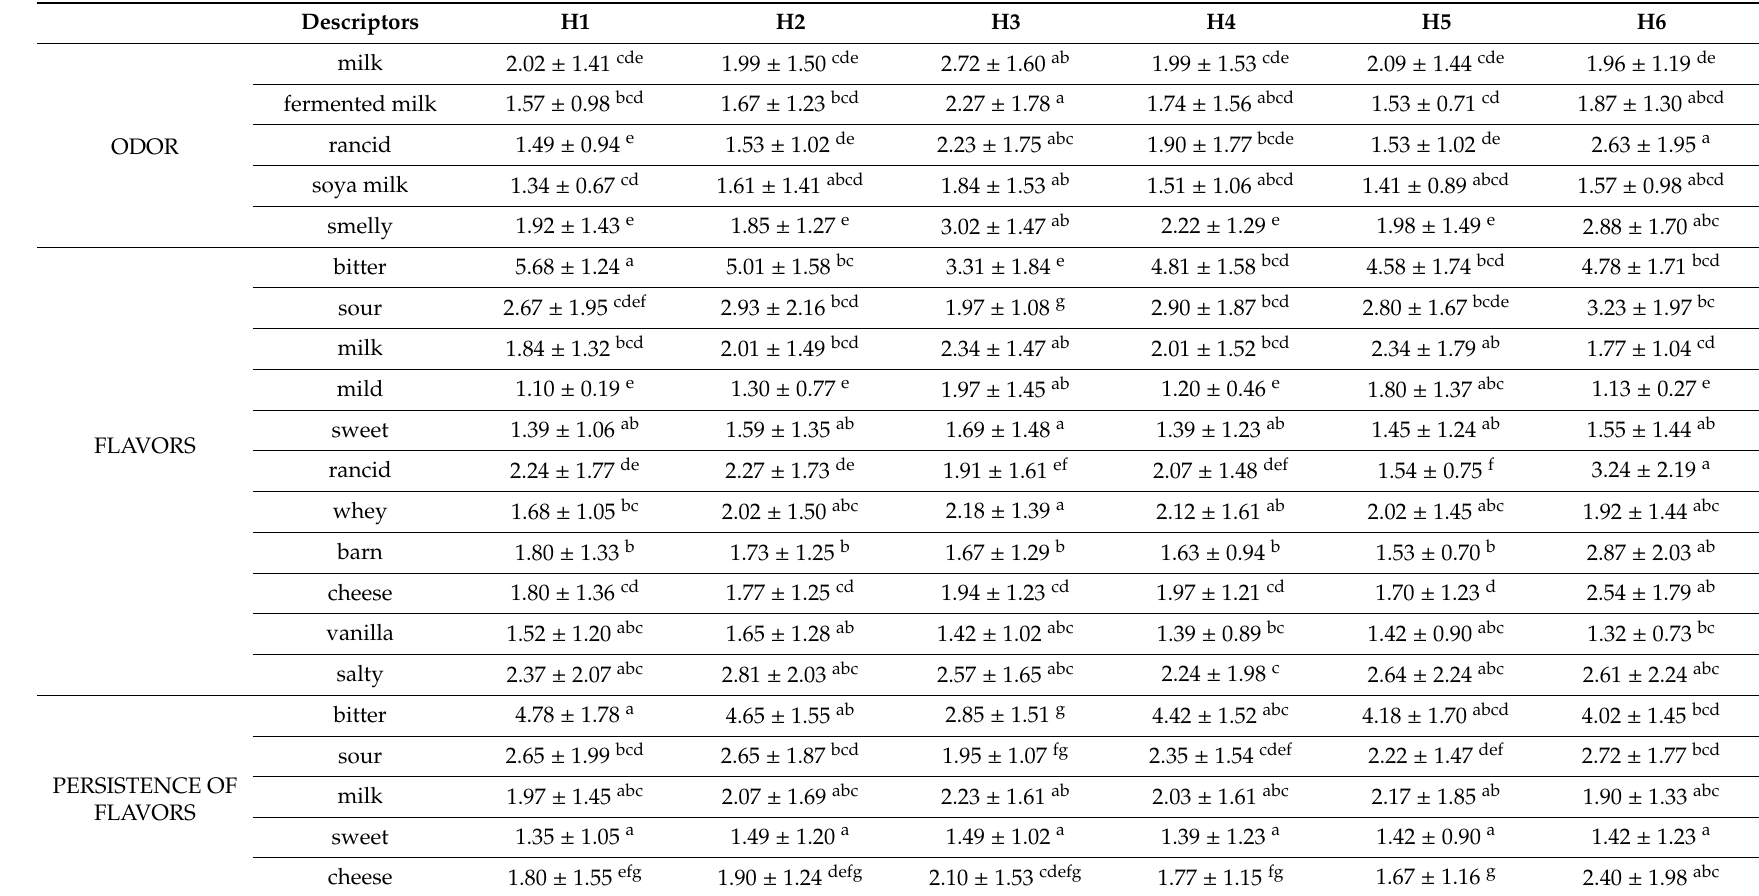
Table 1. Sensory analysis of the seventeen hydrolysates including the Duncan’s multiple range test a